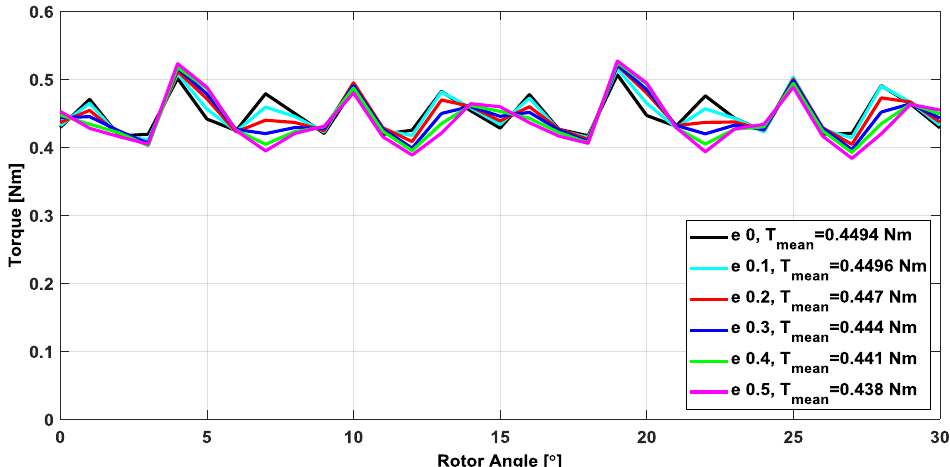
Figure 11. Torques vs. position for the best variant of ZAIM.